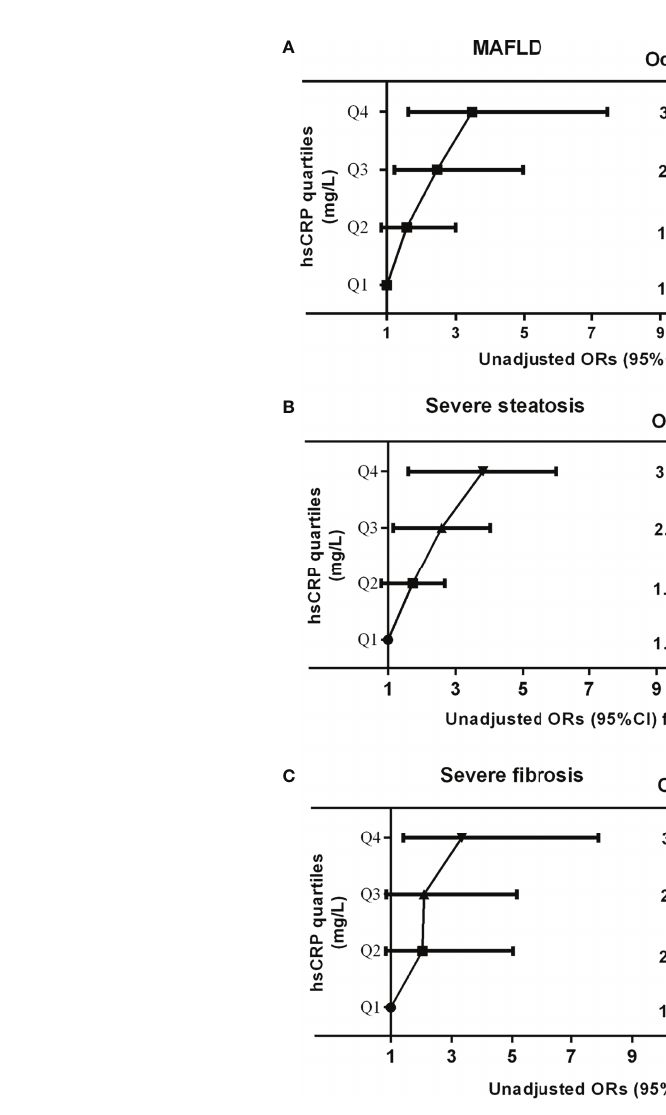
FIGURE 4 | Unadjusted odds ratios (ORs) and 95% con fi dence intervals (CI) for MAFLD, severe steatosis, and severe fi brosis in obese patients according to serum hsCRP quartiles: results of binary logistic regression analysis. Serum hsCRP levels were plotted into four quartiles (Q1, Q2, Q3, and Q4). (A, B) The ORs (95%CI) for MAFLD and severe steatosis in Q3 and Q4 quartile were signi fi cantly higher than that in Q1 quartile (all P- trend < 0.001). (C) The ORs (95%CI) for severe fi brosis in Q4 quartile were signi fi cantly higher than that in Q1 quartile ( P -trend = 0.007). P -values < 0.05 were accepted as statistically signi fi